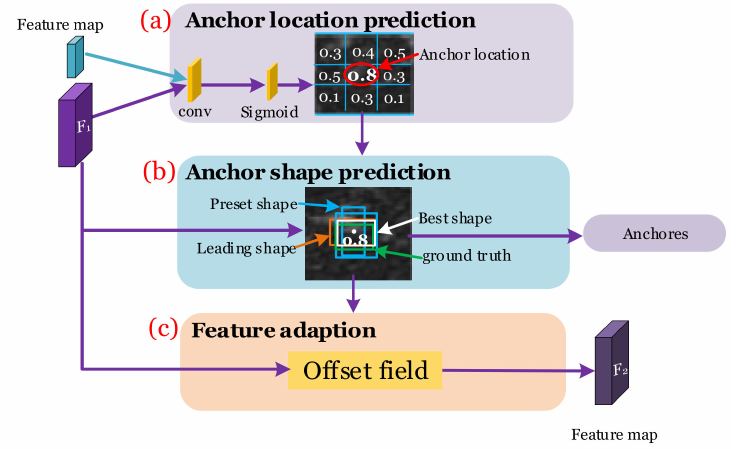
Figure 2. The architecture of GA-SubNet: ( a ) anchor location prediction module generates the sparse location of anchors; ( b ) anchor shape prediction module generates the anchor shape that better conforms to the shape of the shadow; ( c ) feature adaptation module generates a new feature map for the best anchor